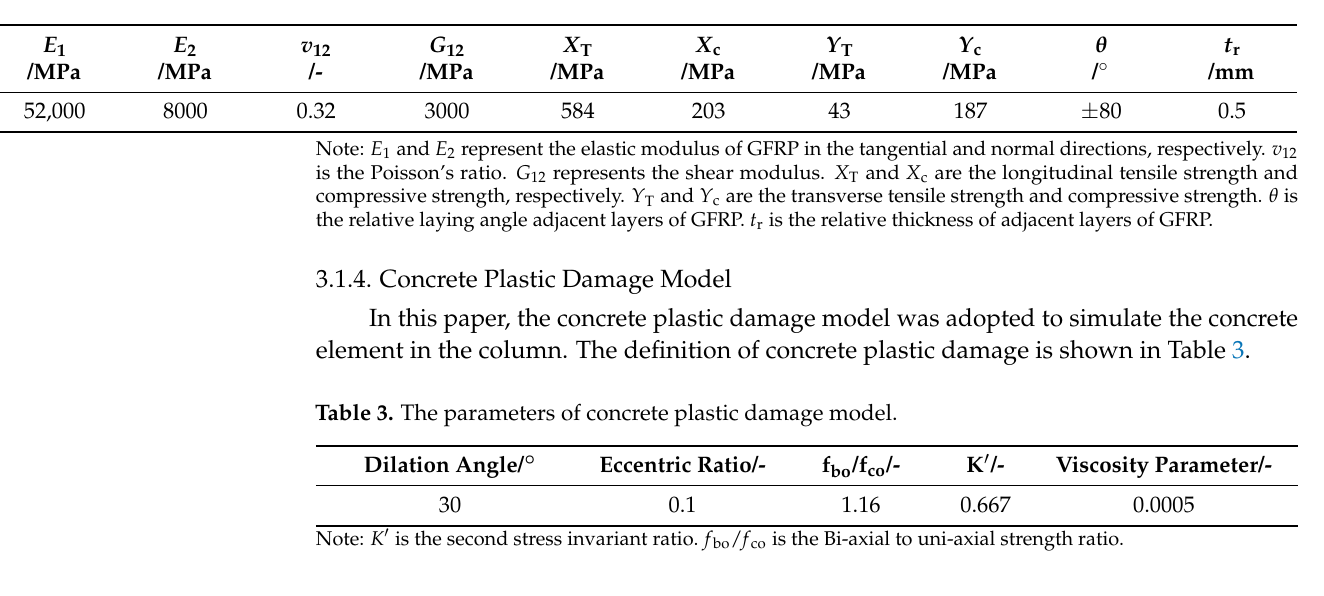
Table 2. Mechanical behavior of the GFRP material.